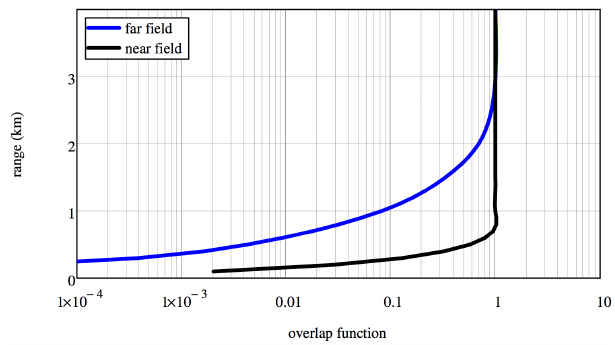
Figure 4. Overlap function for the far- and near-range receiver channels calculated from an optical model of the